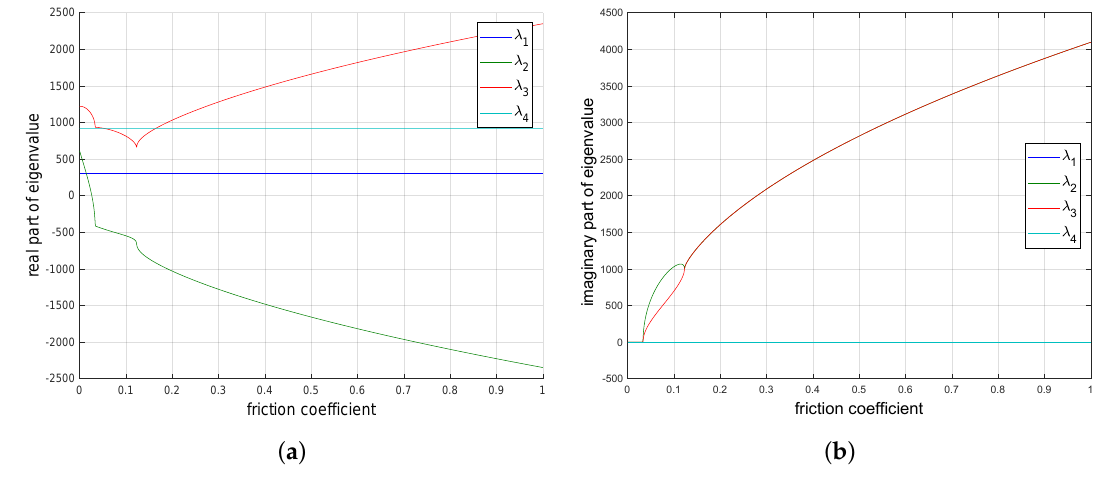
Figure 5. Transversal motion eigenvalues. ( a ) Real part of the eigenvalues; ( b ) imaginary part of the